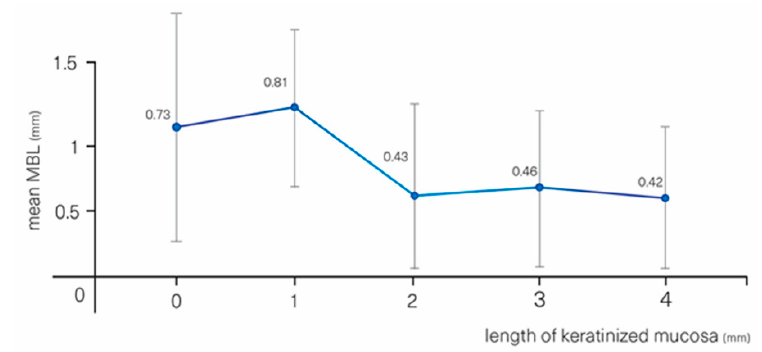
Figure 4. MBL vs. measured keratinized tissue length.